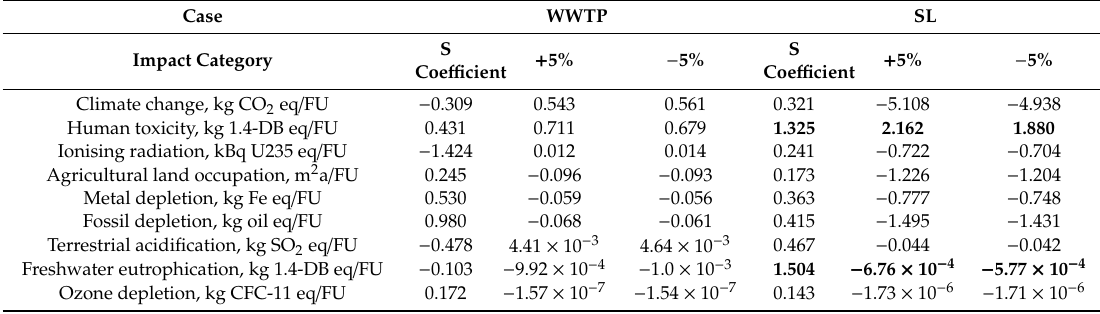
Table 4. Sensitivity coe ffi cients (S) and environmental impacts of the whole WWTP (WWTP-LCA) and SL (SL-LCA) with respect to the TPAD baseline value assumed for the digestate volume.